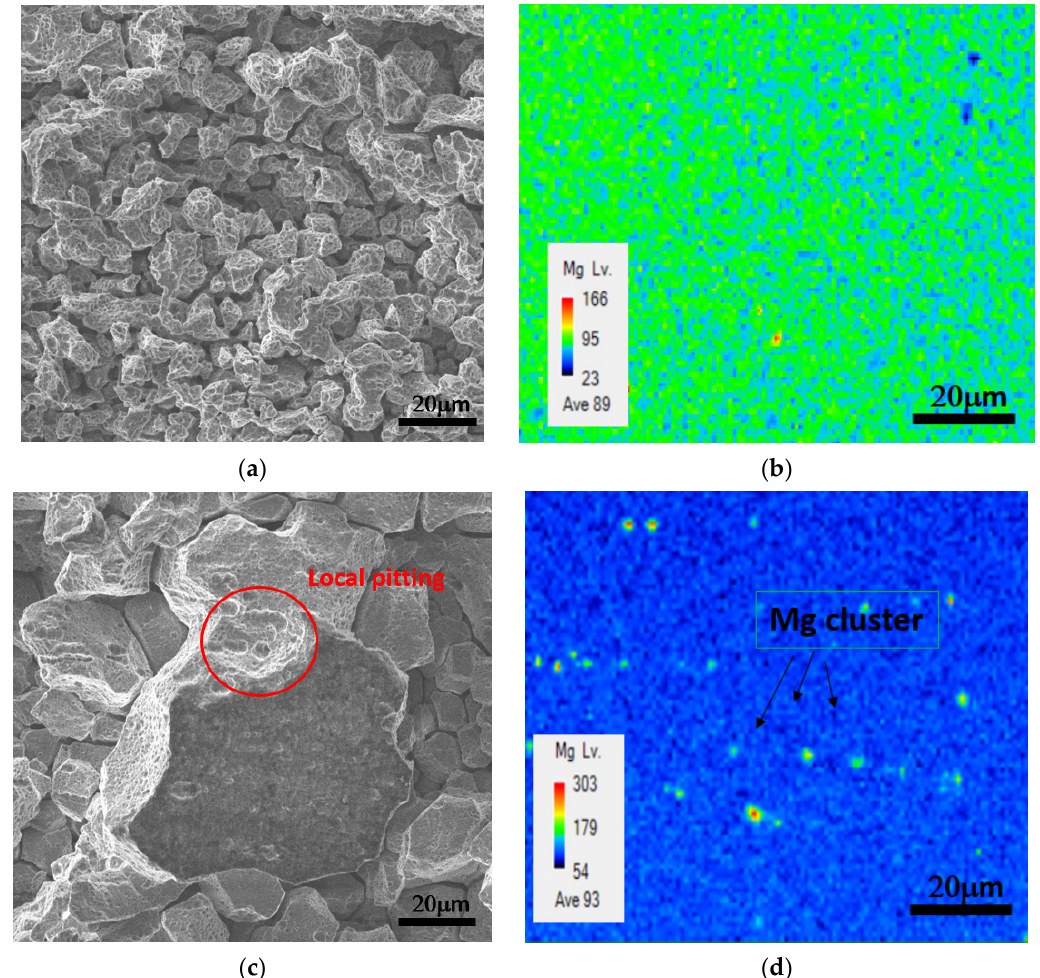
Figure 10. Alloy B(0.1Zr) after sensitization: ( a ) SEM morphology of localized surface corrosion when annealed at 350 °C; ( b ) EPMA mapping of Mg element annealed at 350 °C, ( c ) SEM morphology of localized surface corrosion when annealed at 450 °C, ( d ) EPMA mapping of Mg element annealed at 450 °C.